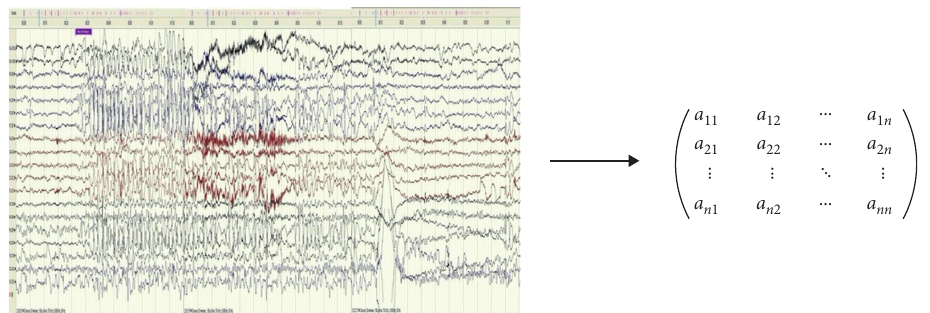
Figure 2: EEG signals during an epileptic seizure of Patient A at a time t is transformed into a square matrix [30].